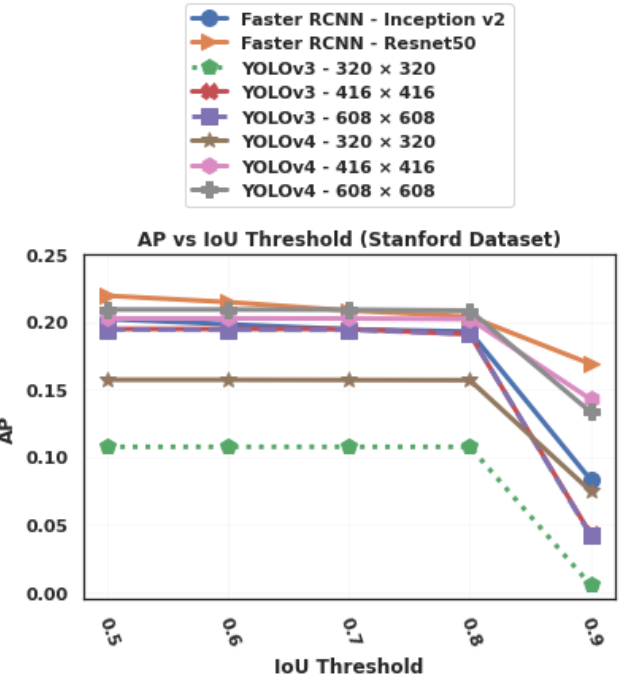
Figure 18. AP (Average Precision), at different IoU (Intersection over Union) threshold values, of the tested algorithms on the Stanford